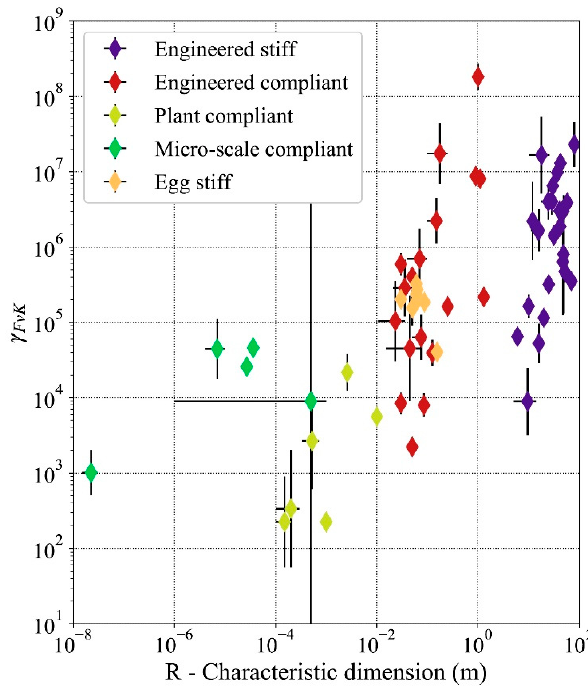
Figure 3. Föppl–von K á rm á n number, γ FvK , in thin shells as a function of the characteristic dimension. The scale for both axes is logarithmic.